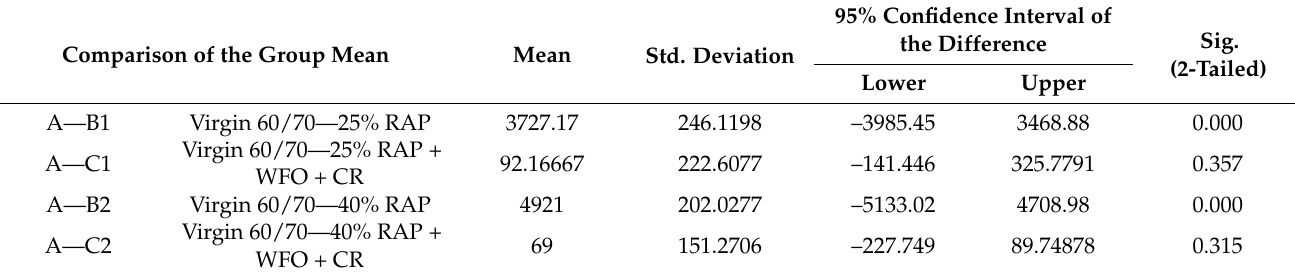
95% Confidence Interval